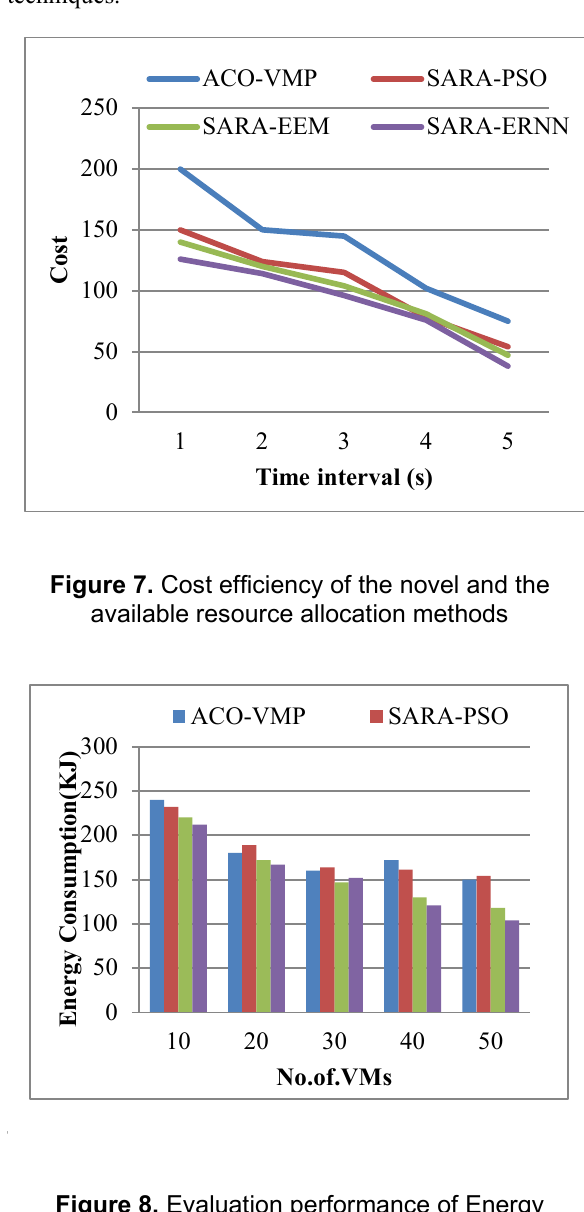
Figure 8. Evaluation performance of Energy Consumption range of the discussed and available resource allocation